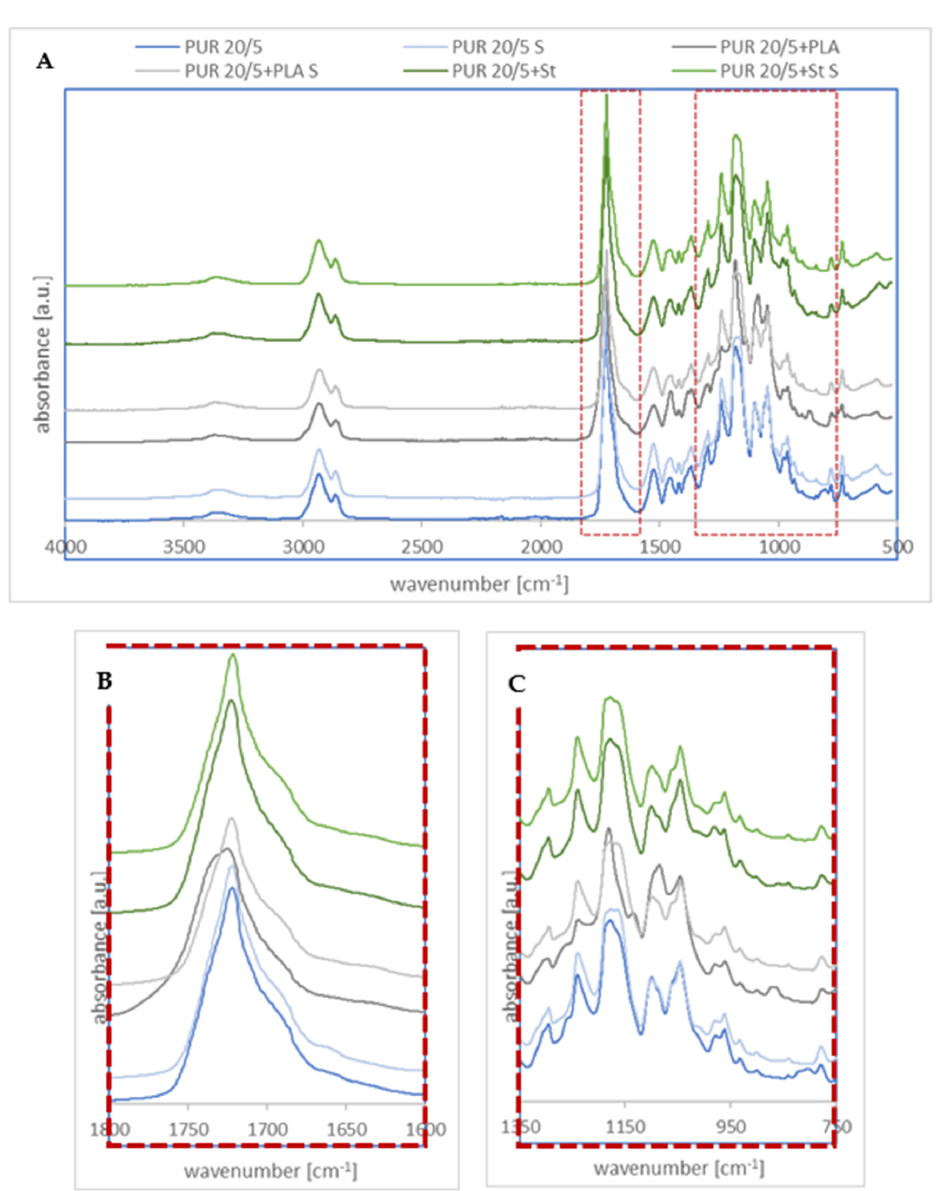
Figure 2. Examples of ATR-FTIR spectra of PUR 20/5 and its blends before and after 36 weeks of sample exposure to soil in the wavenumber of 500–4000 cm − 1 ( A ), 1600–1800 cm − 1 ( B ) and 750–1350 cm − 1 ( C